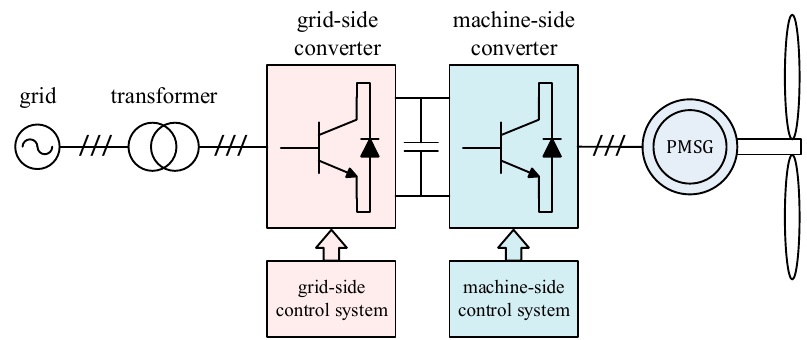
Figure 1. Schematic diagram of the direct-drive permanent-magnet wind generator.